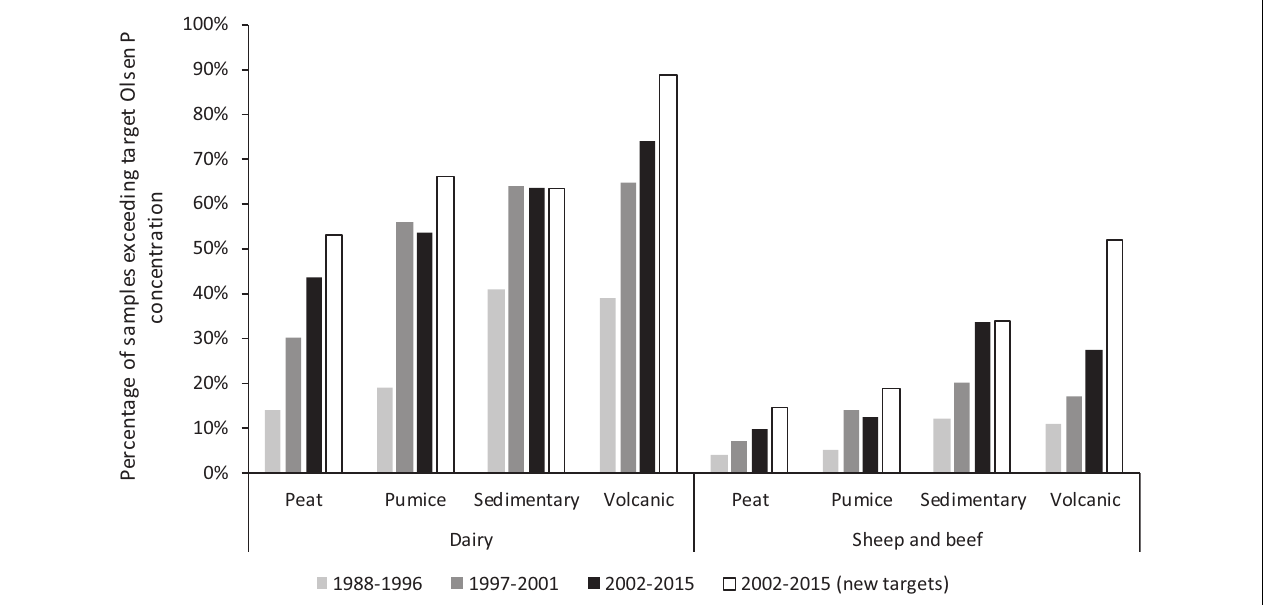
FIGURE 1 | The percentage of samples collected in 1988–1996, 1996–2001, and 2002–2015 exceeding target ranges in Olsen P for each soil group in dairy or sheep and beef land use. Data for 1988–2001 and targets (45, 45, 25, and 30 mg L − 1 for Peat, Pumice, Sedimentary, and Volcanic soils, respectively) were taken from Wheeler et al. (2004). Targets used in this paper are referred as “new